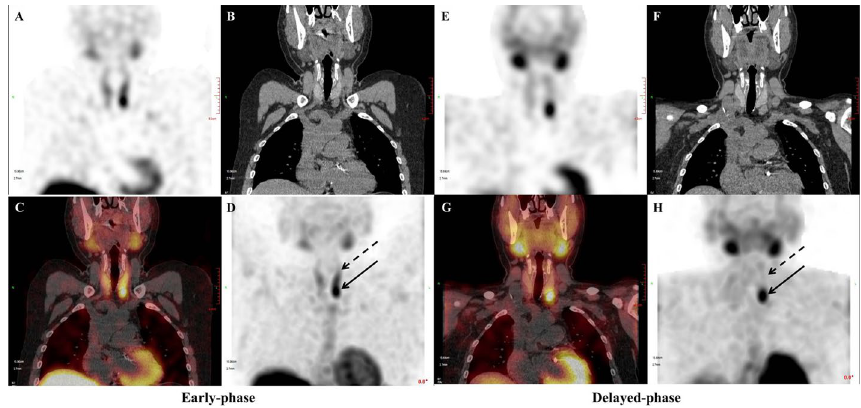
Fig. 4 Early phase of coronal SPECT ( A ), coronal CT ( B ), coronal SPECT/CT ( C ) and MIP ( D ) images from 99mTc-MIBI displaying a clear thyroid image (dotted arrow), with focal imaging agent concentration below the inferior pole of the left lobe (arrow). Delayed phase of coronal SPECT ( E ), coronal CT ( F ), coronal SPECT/ CT ( G ) and MIP ( H ) images showed significant tracer washout from the thyroid (dotted arrow) while high concentration persisted in the lesion below the inferior pole of its left lobe (arrow). MIP is maximum intensity